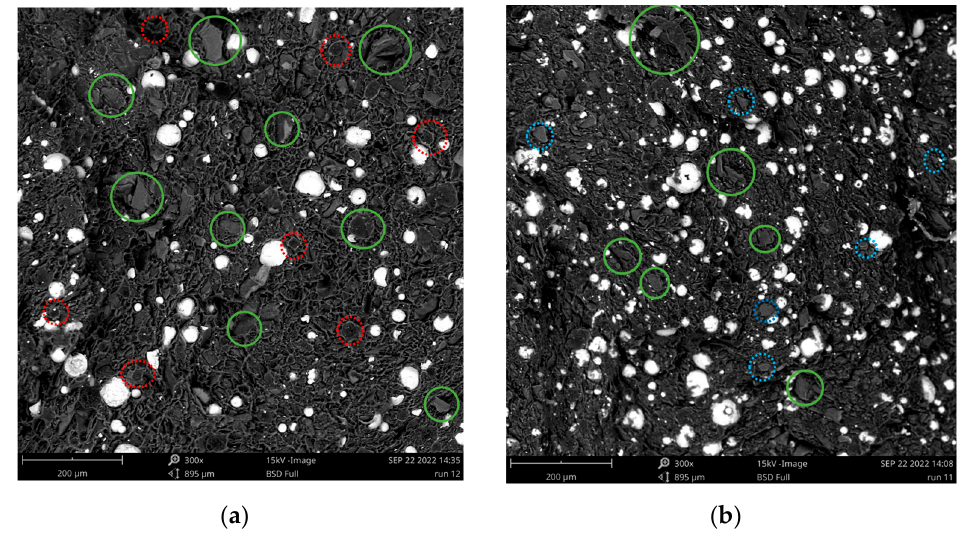
Figure 5. SEM images of the filler dispersion in the HDPE matrix; ( a ) Run 12 (22.5 m.% Al 2 O 3 /6.25 m.% EG); ( b ) Run 11 (45 m.% Al 2 O 3 /6.25 m.% G/6.25 m.% EG)—the green circles indicate the EG, the blue circles indicate the G and the red circles indicate spherical indentations. The white spheres in both figures are the Al 2 O 3 particles.